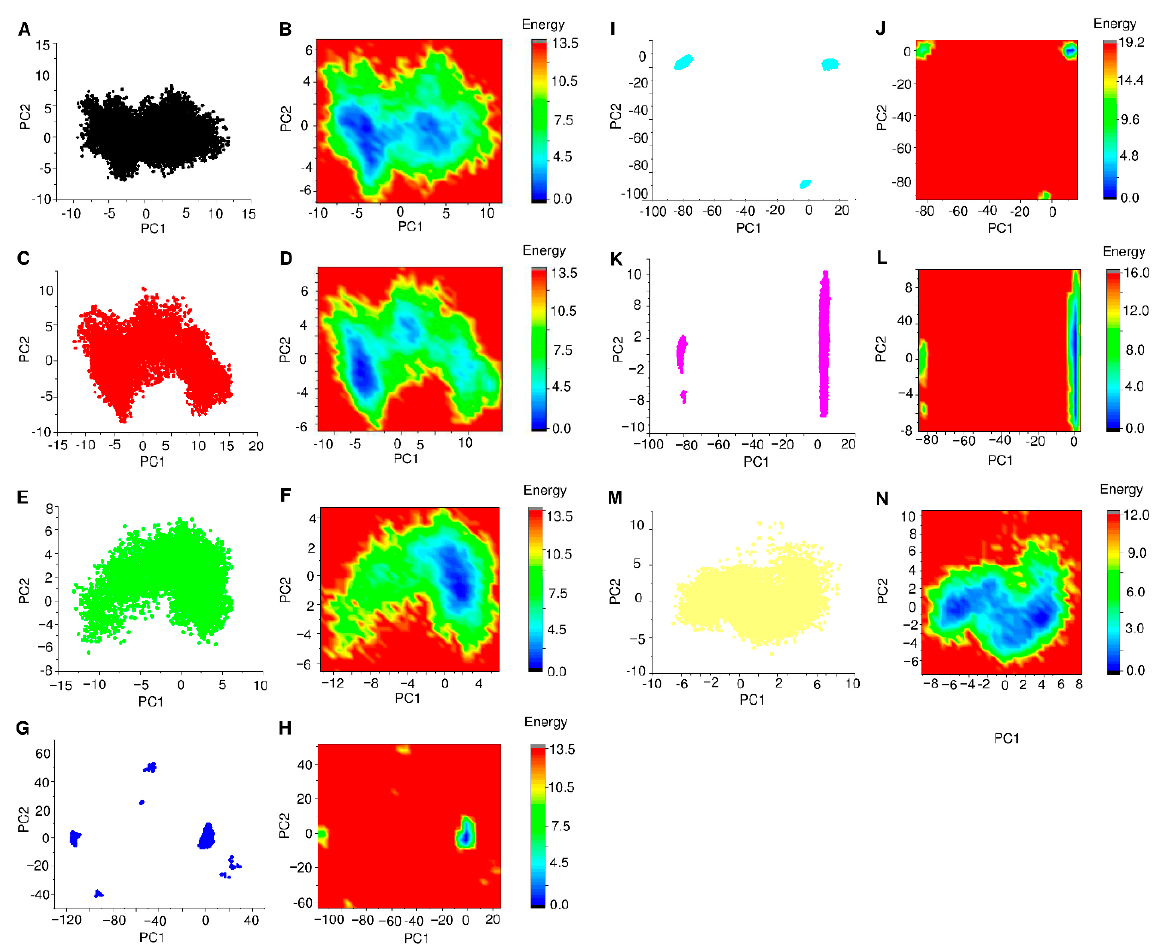
Figure 7. PCA of ( A ) apo, ( C ) LCI-bound, ( E ) geniposidic-acid-bound, ( G ) quercetin-bound, ( I ) geniposide-bound, ( K ) curcumin-bound and ( M ) withanolide-bound CDK9/cyclin T1. Free energy landscapes of ( B ) apo, ( D ) LCI-bound, ( F ) geniposidic-acid-bound, ( H ) quercetin-bound, ( J ) geniposide-bound, ( L ) curcumin-bound, and ( N ) withanolide-bound CDK9/cyclin T1. Two large troughs were found in the apo and LCI-bound CDK9/cyclinT1. Simultaneously, withanolide-bound CDK9/cyclinT1 exhibited a single and large energy valley. Interestingly, geniposidic-acid-bound has a single, exact deep-blue patch seen.